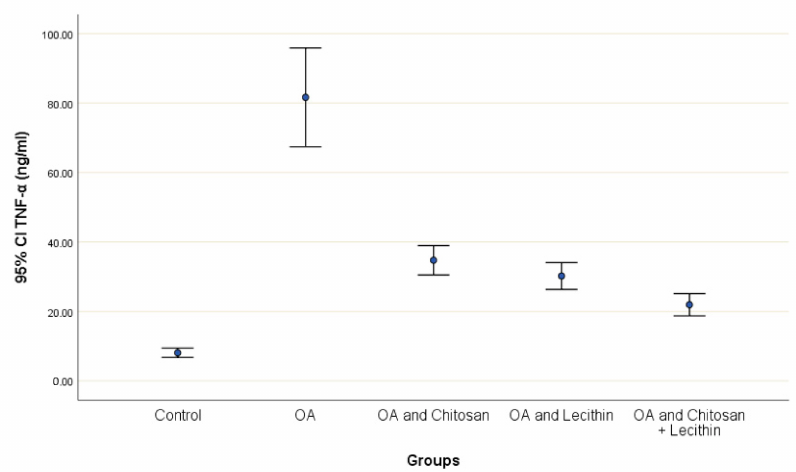
Figure 2. The e ffi cacy of chitosan and lecithin against tumor necrosis factor-alpha (TNF- α ) in (OA) model induced by monoiodoacetate (MIA). The data presented as mean ± S. E.